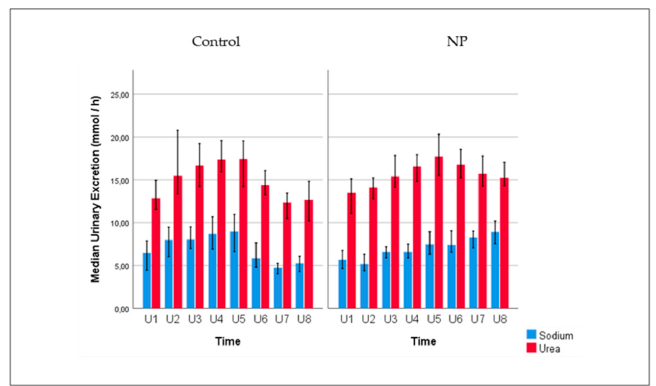
Figure 1. Urinary excretion of urea and sodium (mmol/hour) for subjects with and without NP (control) according to eight urine samples collected over 24 h. Daytime urine samples were collected between 8–11 a.m. (U1), 11 a.m.–2 p.m. (U2), 2–5 p.m. (U3), 5–8 p.m. (U4), and 8–11 p.m. (U5). Nighttime